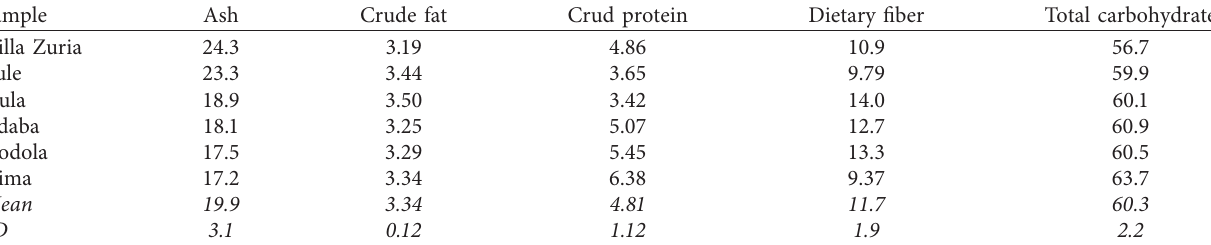
Table 2: Proximate composition (% w/w dry matter) of the leaves of Urtica simensis samples collected from six different locations in Ethiopia. The overall mean and standard deviation (SD) across the different samples are also included in the